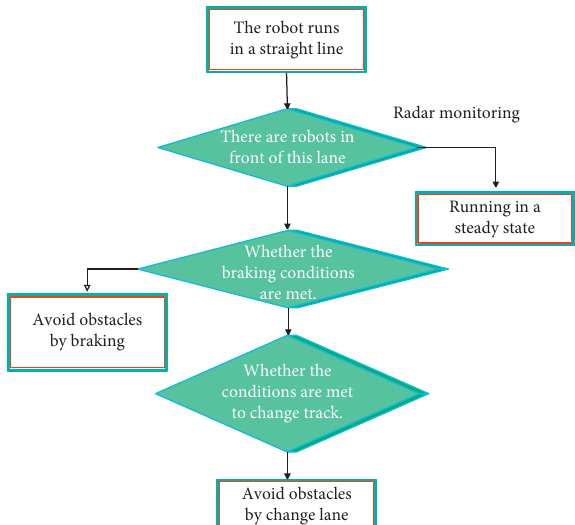
Figure 7: Flowchart of the decision-making